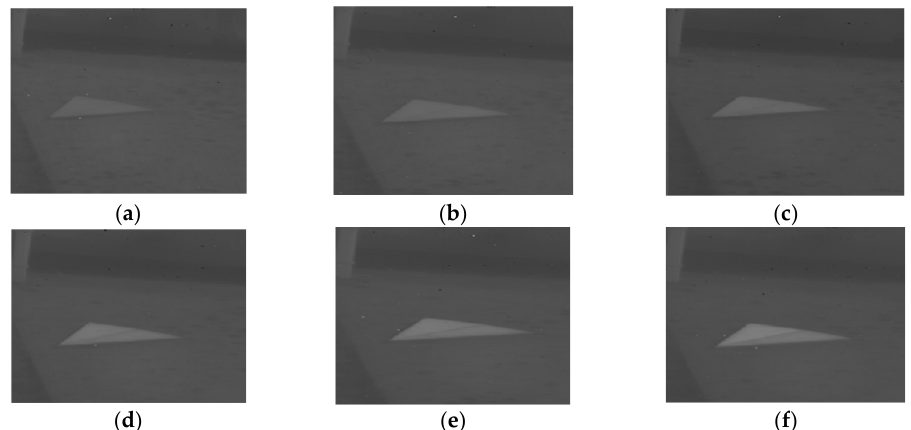
Figure 8. Heating plates with different temperatures in degree C: ( a ) 35; ( b ) 38; ( c ) 41; ( d ) 44; ( e ) 47; ( f ) 50. The atmospheric parameters for the fan-shaped target test are listed in Table 7. The transmittance and atmospheric radiation are calculated by Equation (12) with Table 7. Atmospheric parameters used in MODTRAN for the fan-shaped target test. values of 73.3% and 1.17 W/m 2 /sr, while by MODTRAN with values of 72.3% and 1.34 W/m 2 /sr, respectively. Table 8 shows the comparison of inversion results for the two hearting plates, indicating that for each row, the radiance derived from the analytical expression is also closer to the actual radiance than that from MODTRAN over a relatively long distance, with the maximal error of 10.2% and 16.7% by the derivation from the analytical expression and by MODTRAN,